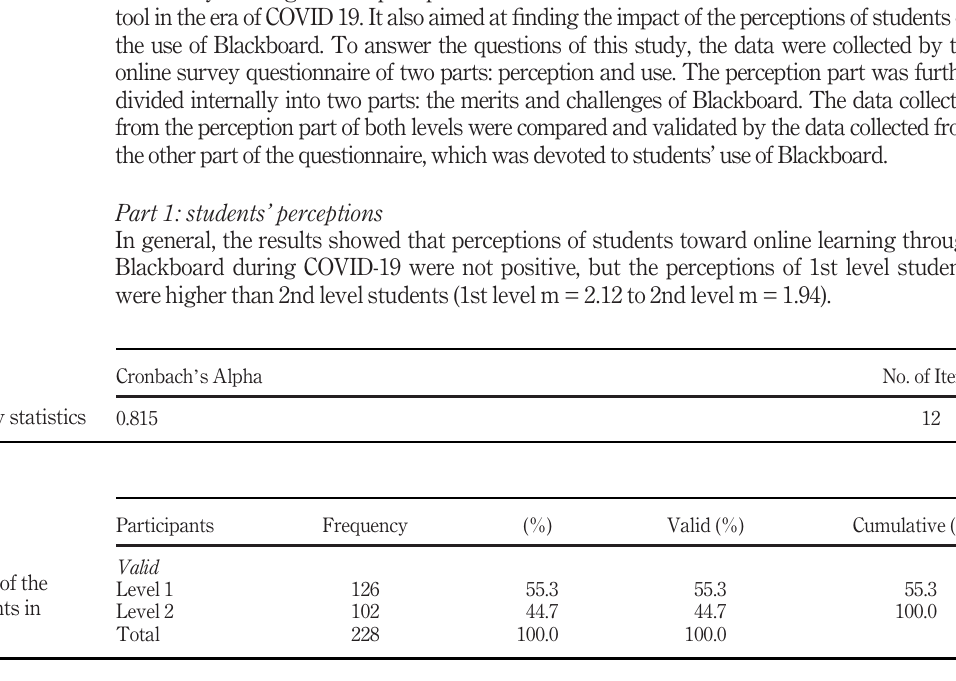
Table 2. Statistics of the participants